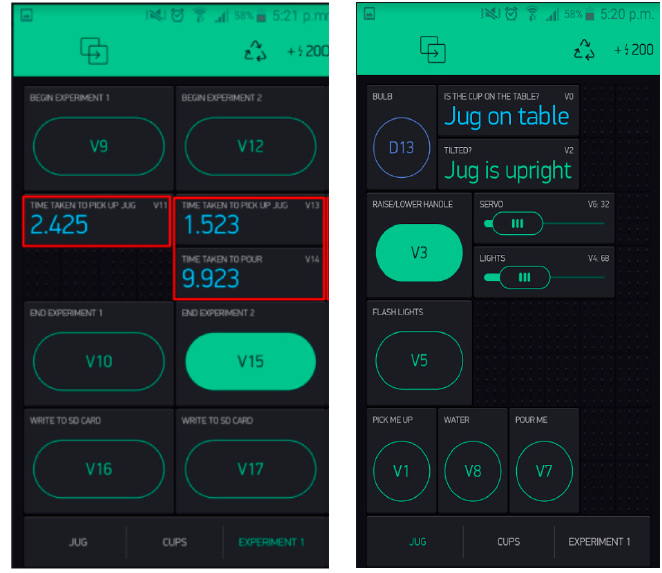
Figure 7. Screenshots of app showing timings for experiments 1 and 2.